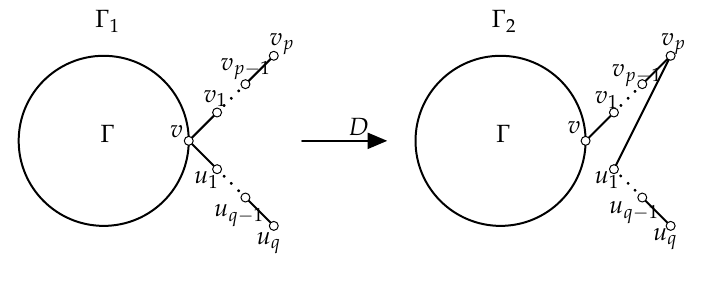
Figure 1. Transformation D